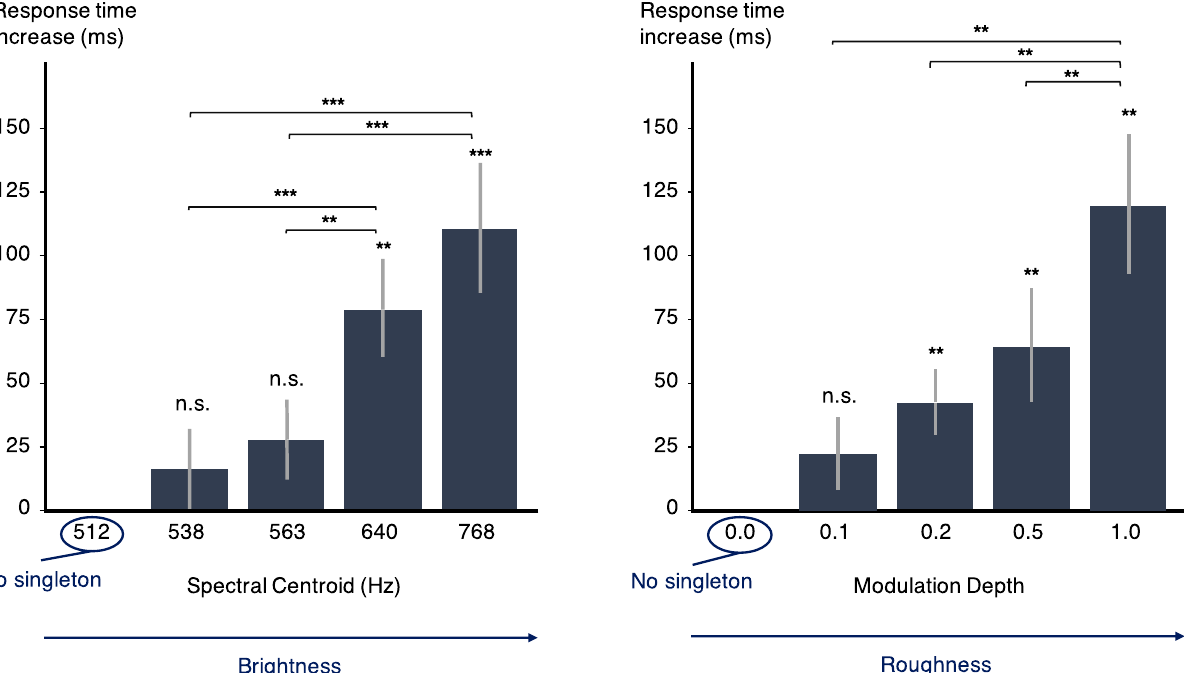
Figure 2. Increase in response time (ms) with singleton SC (left, experiment 2) and modulation depth (right, experiment 3). Error bars represent the standard errors across participants in each condition compared to the no-singleton condition. Significances between conditions are displayed on the horizontal braces. *: p < .05, **: p < .01, ***: p <